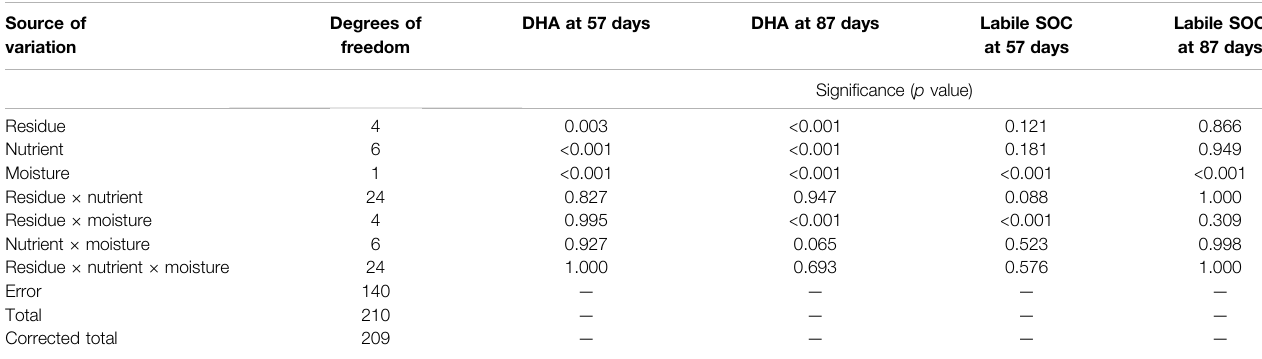
TABLE 6 | ANOVA for dehydrogenase activity (DHA) and labile SOC at 57 and 87 days of incubation. Source of variation